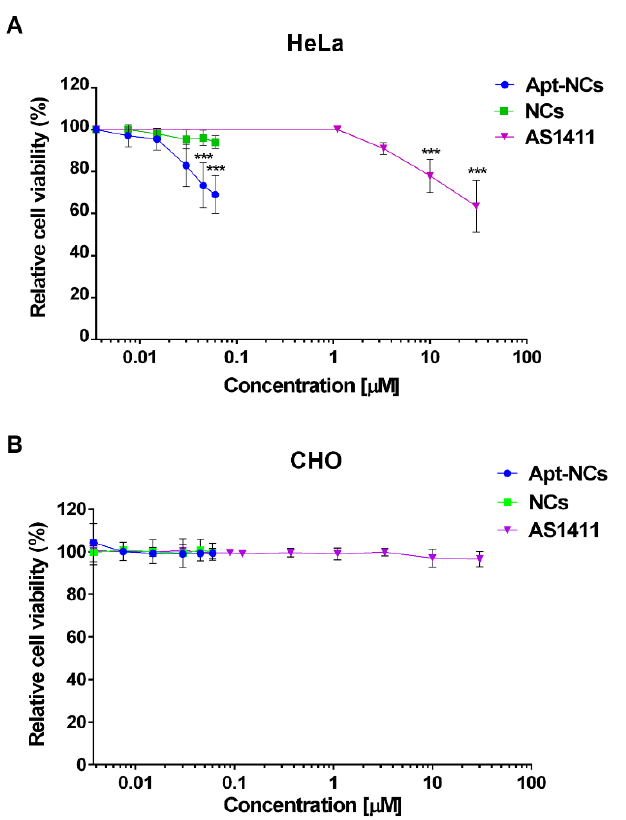
Figure 5. Cytotoxic effect of Apt-NCs in HeLa ( A ) and CHO cells ( B ). Cell proliferation after 24 h treatment with Apt-NCs, non-functionalized NCs, and free AS1411 at different concentrations was assessed by MTS. The values are the means of six replicates normalized to untreated cells. Statistical significance: (***) p < 0.001 (Student’s t -test) compared with NCs treated cells in the case of Apt-NCs and untreated cells in the case of AS1411.